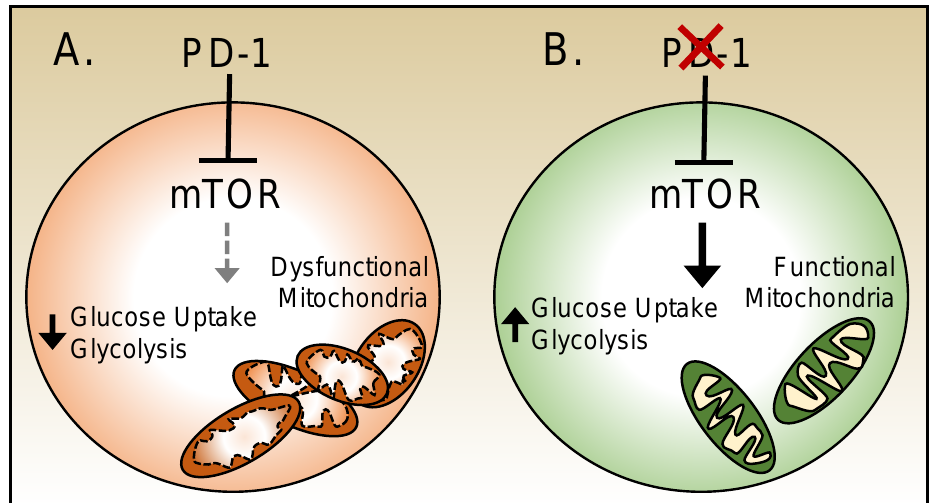
Figure 4. PD-1 and mTOR modulate metabolism in exhausted T cells. ( A ) During chronic viral infections PD-1 expression by exhausted CD8 T cells contributes to aberrant mTOR signals, which reduces glucose uptake and glycolysis, and also leads to an increased mass of disorganized and dysfunctional mitochondria. ( B ) Ablation of PD-1 enhances mTOR signals. This increases glucose uptake and glycolysis, as well as results in more organized and functional